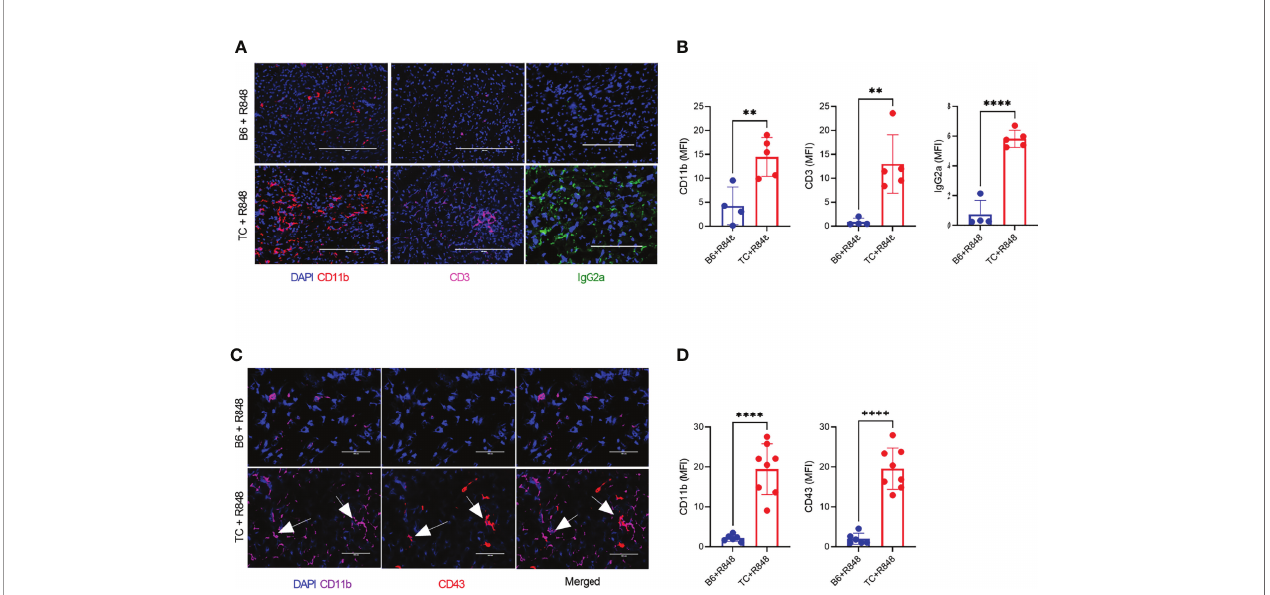
FIGURE 2 | TLR7 activation induces immune cell in fi ltration in the heart of TC mice. (A) Representative heart sections stained for CD11b, CD3 and IgG2a (20X scale bars: 200 um). (B) Quanti fi cation of CD11b + and CD3 + cells as well as IgG2a deposits (MFI, mean fl orescence intensity). (C) Representative heart sections co- stained with CD11b and CD43 (40X, scale bars: 50 um). (D) Quanti fi cation of CD11b + and CD43 + in fi ltrates (MFI). Arrows indicate co-staining. n = 5 - 12 treated mice per strain. t tests, ** P < 0.01, **** P <